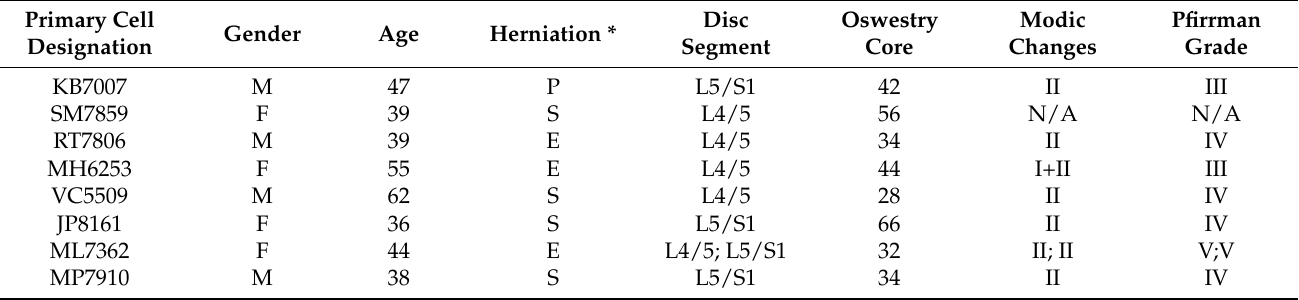
Table 1. Characteristics of patients undergoing spinal